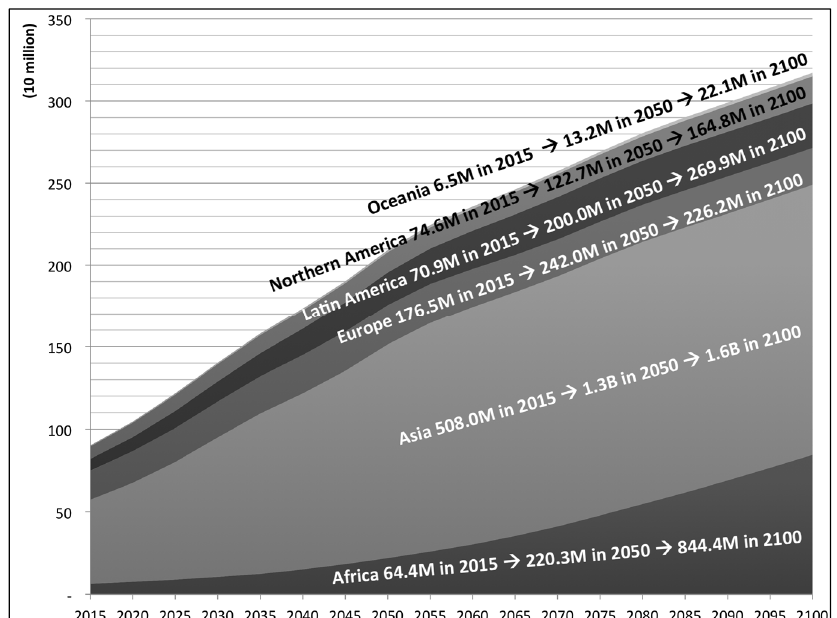
Figure 2. Trends of the aged 60-plus population in six regions of the world. Note: Created from population estimations for 1950–2010 and population projections with medium fertility rate for 2015–2100 by the United